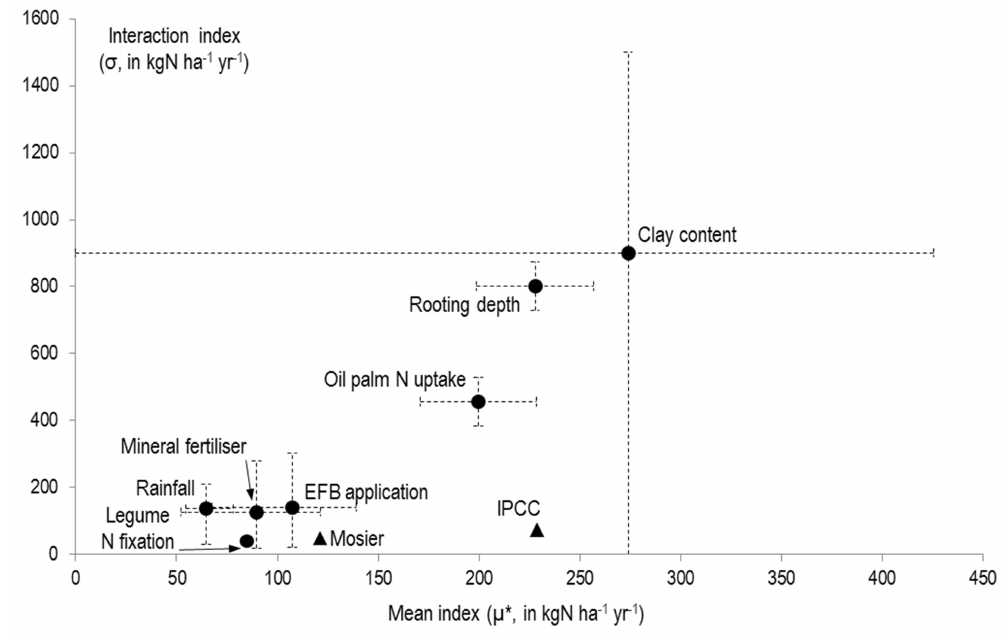
Figure 9. Morris’s sensitivity indices for five sub-models calculating leaching and runoff losses. Clay content, rooting depth, and oil palm N uptake had high interaction indices, and they had the most important mean indices with IPCC (2006) emission factor. Sub-models tested: IPCC-2006, Mosier, Smaling, de Willigen, and SQCB-NO3. Indices lower than 50kg Nha − 1 yr − 1 are not represented. Triangles: emission factors; circles: N inputs, oil palm and environment characteristics. EFB: empty fruit bunches, i.e. organic fertiliser.